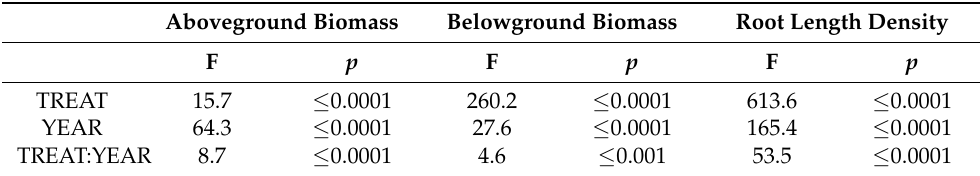
Table 2. Two-factorial analyses of a mixed model on the significance of the effects of mixture or monoculture system (TREAT), year (YEAR), and their interaction (TREAT:YEAR) on the variance of aboveground biomass, belowground biomass, and root length density (RLD) of the species sum white clover and perennial ryegrass.